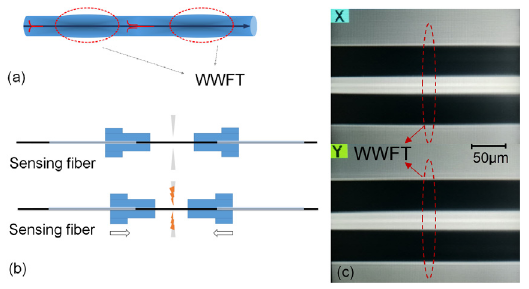
Figure 1. Schematic of WWFT and its fabrication: ( a ) Schematic of WWFT and the constructed intermodal interferometer; ( b ) Inline fabrication of WWFT; ( c ) XY side views of the fiber taper with overlap of 20 µ m. The red circle represents the fiber taper